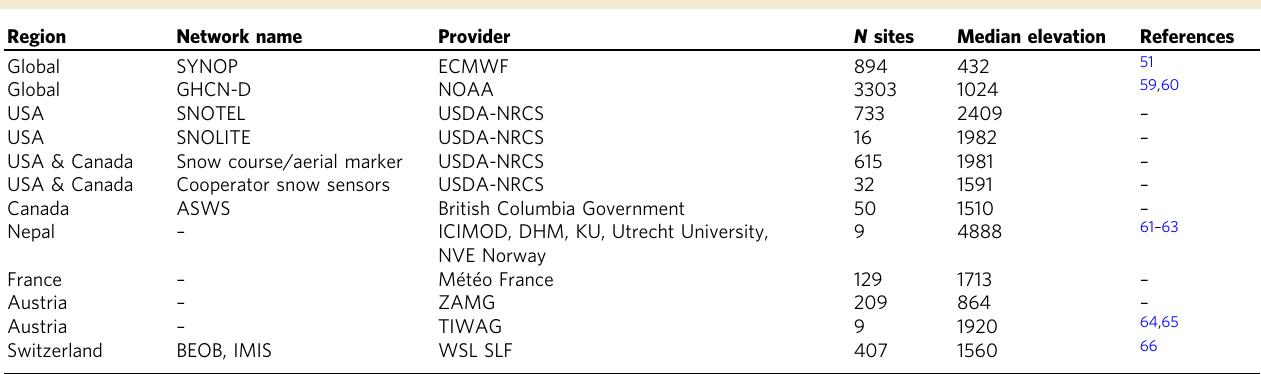
Table 1 Description of the in situ measurements Region